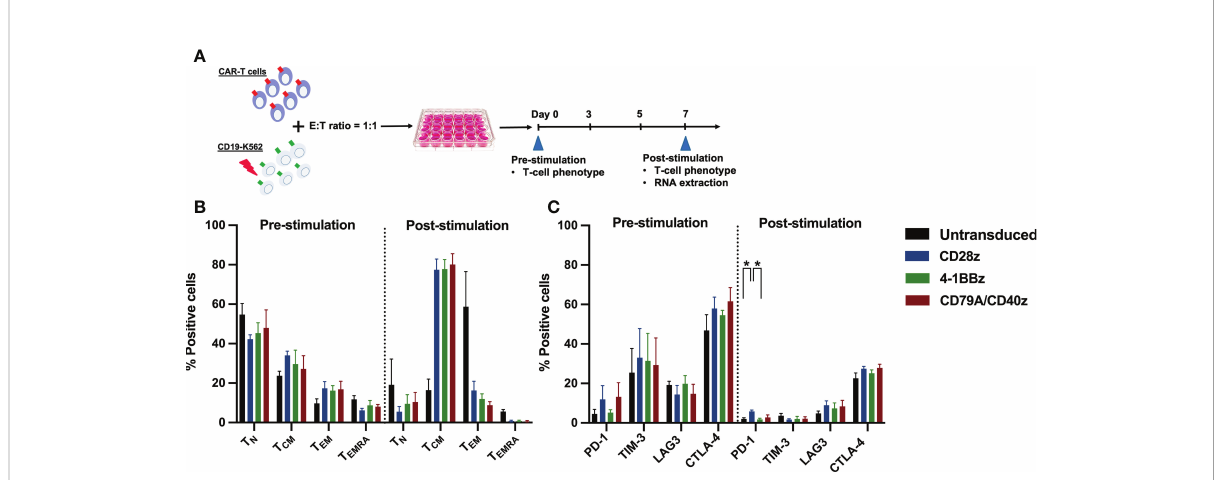
FIGURE 2 CAR-T cell immunophenotype assays. (A) Experimental schematic of antigen stimulation and CD19CAR-T cell phenotype assays. CD19CAR-T cells were stimulated with g -irradiated CD19-K562 cell line in a 1:1 ratio for seven days and cultured without IL-2 supplementation. Then, the CD19CAR-T cell proliferation, T-cell differentiation, and exhaustion phenotypes were assessed before and after stimulation on day 0 and day 7, respectively. The remaining CD19CAR-T cells 3 – 6 x 10 6 cells were harvested at post stimulation on day 7 and extracted for RNA for further RNA sequencing. (B) The percentages of T-cell differentiation subsets were determined by CD62L + CD45RA + naïve T (T N ), CD62L + CD45RA - central memory T (T CM ), CD62L - CD45RA - effector memory T (T EM ), and CD62L - CD45RA + effector memory re-expressing CD45RA T (T EMRA ) cells before and after stimulation. (C) The percentage of T-cell exhaustion was determined by exhausted T-cell markers PD-1 + , TIM-3 + , LAG-3 + , and CTLA-4 + before and after stimulation. Data were pooled from three different donors and are shown as mean ± SEM; One-way ANOVA for (B, C) ; *p <